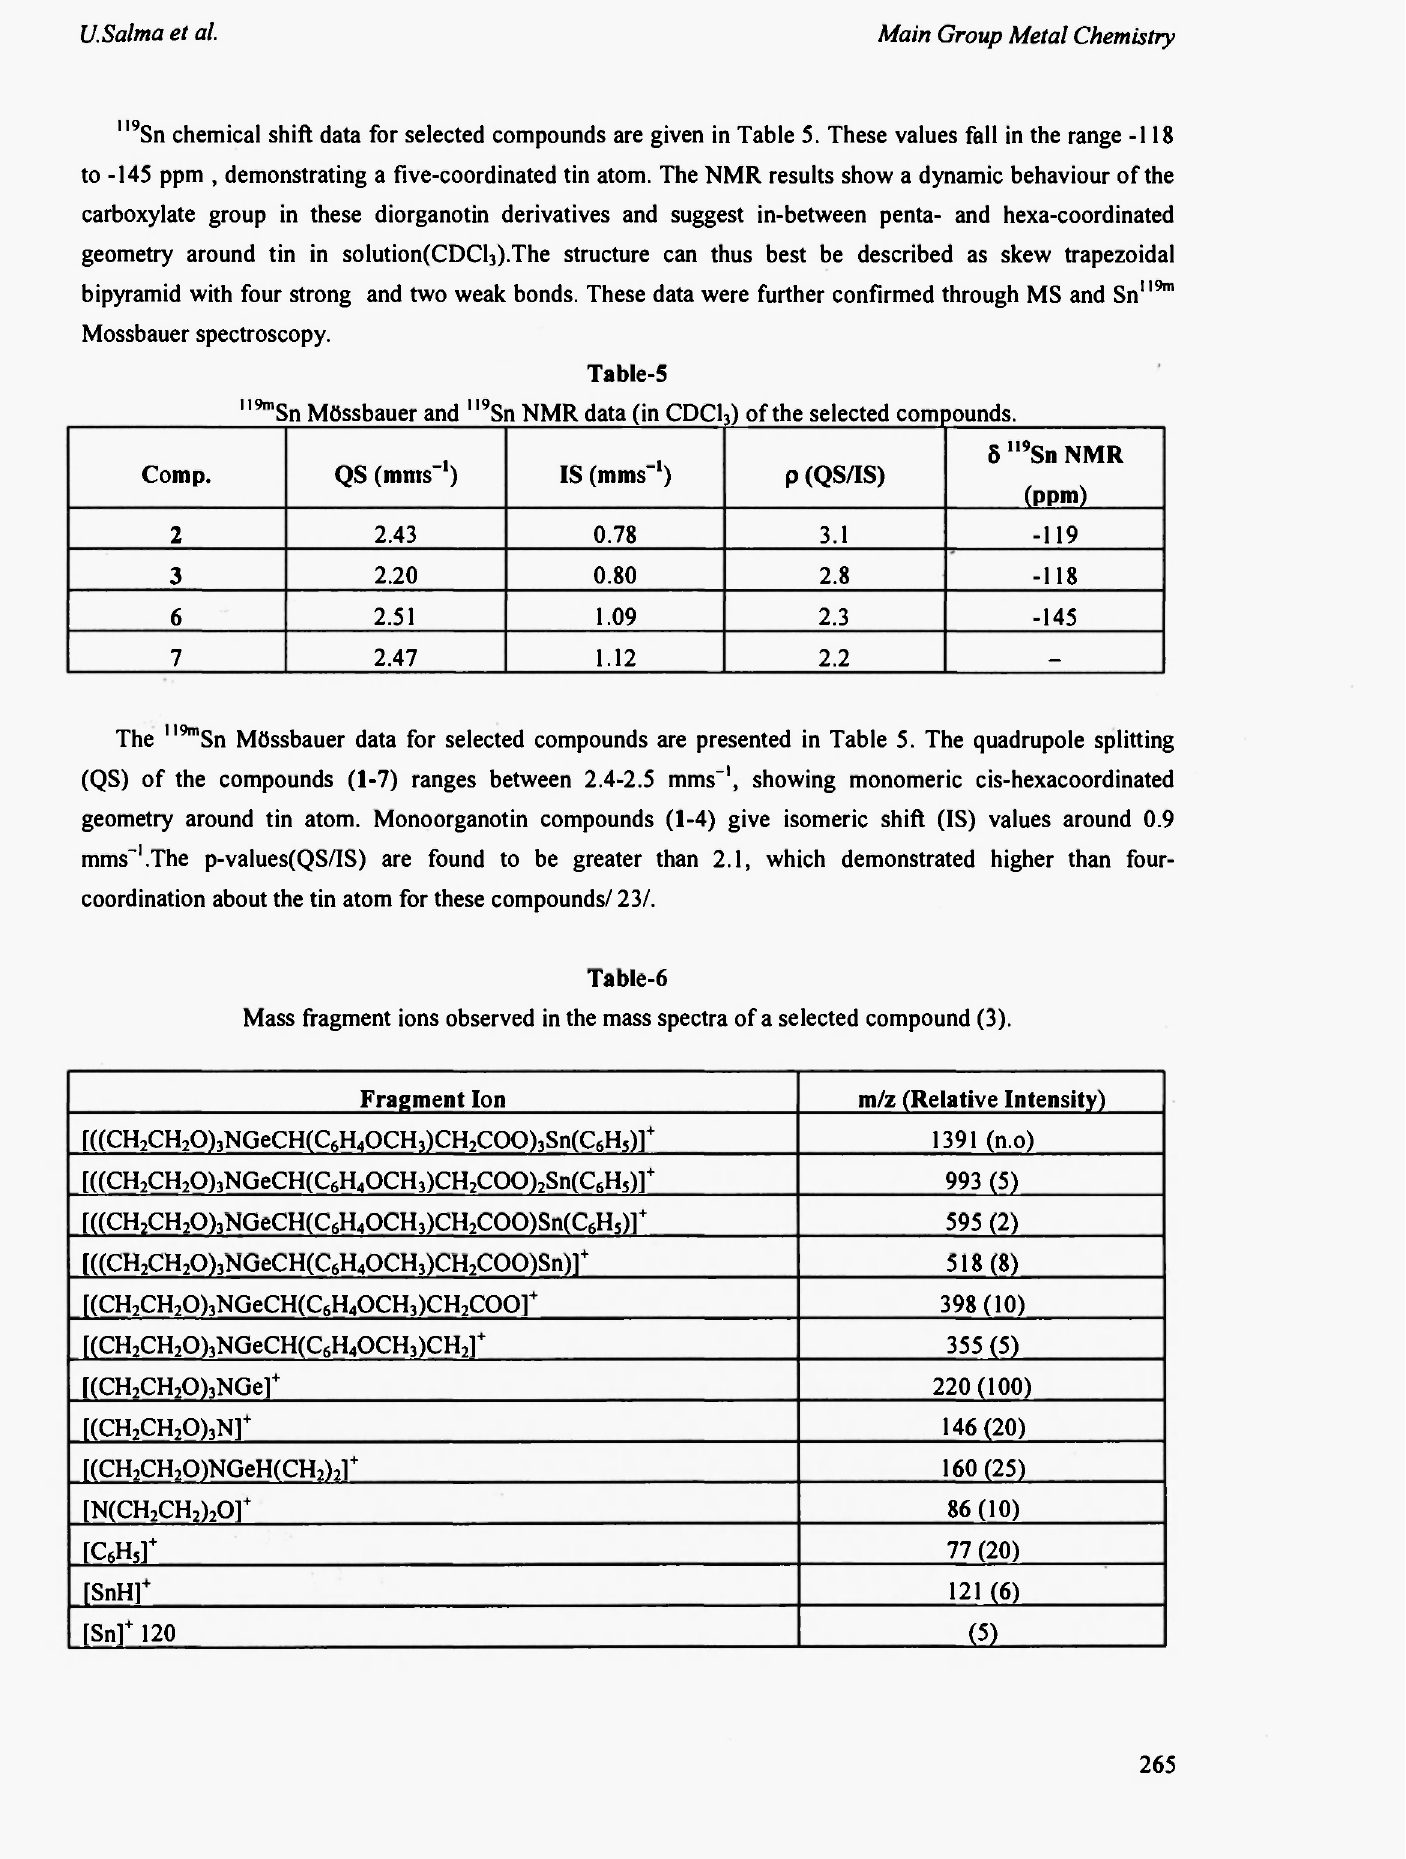
Mass fragment ions observed in the mass spectra of a selected compound